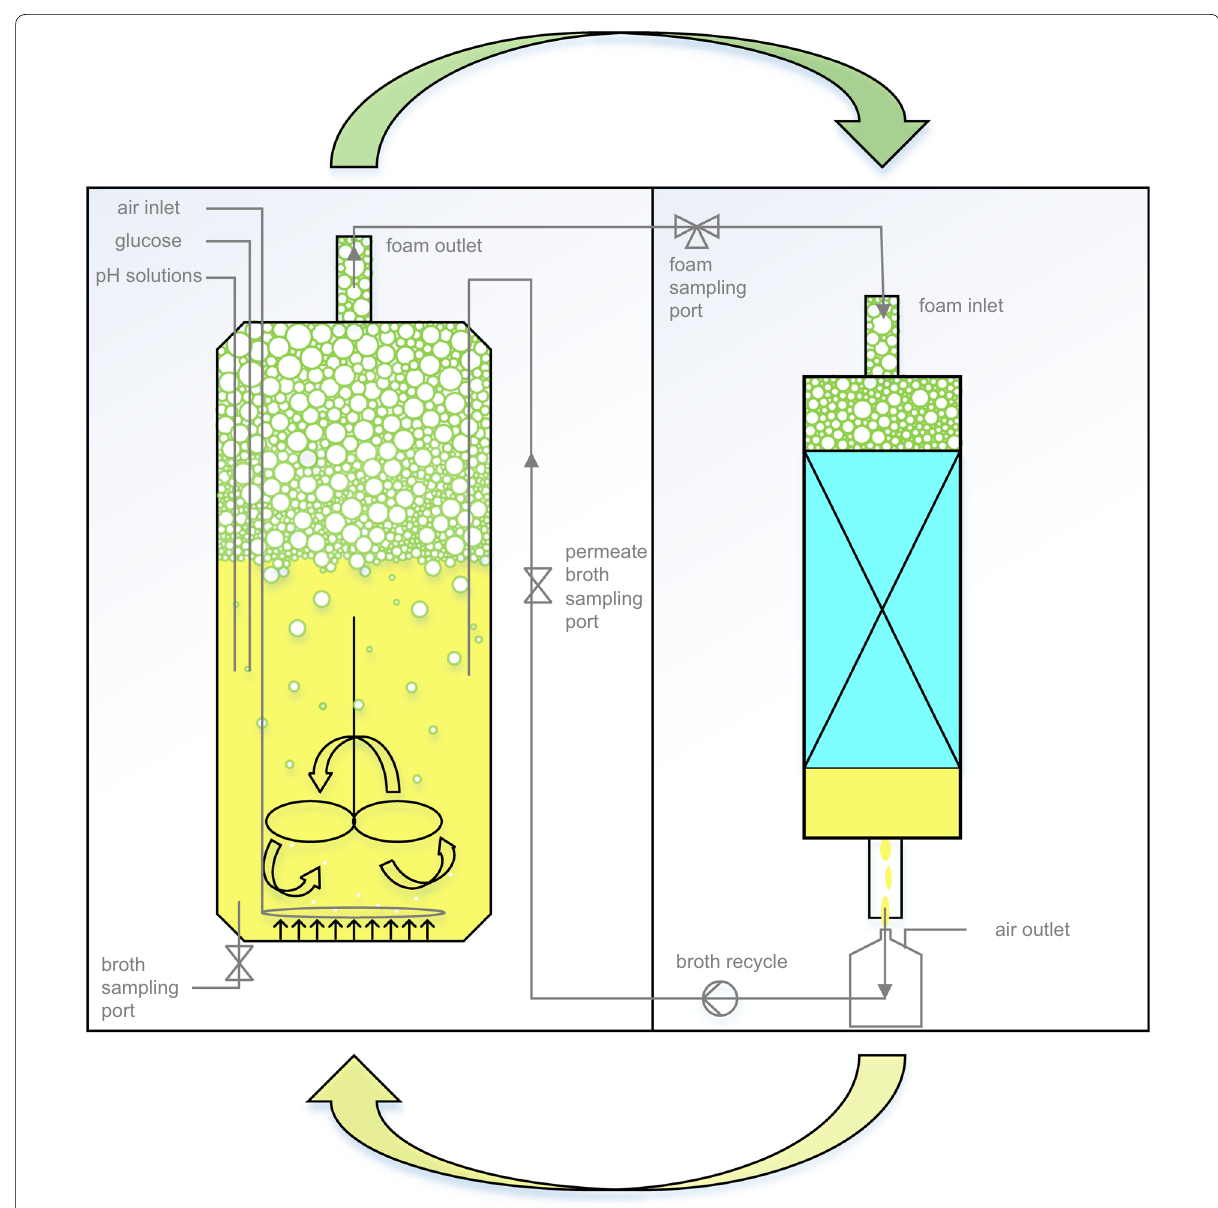
Fig. 1 Concept of rhamnolipid separation from fermentation broth using foam technology